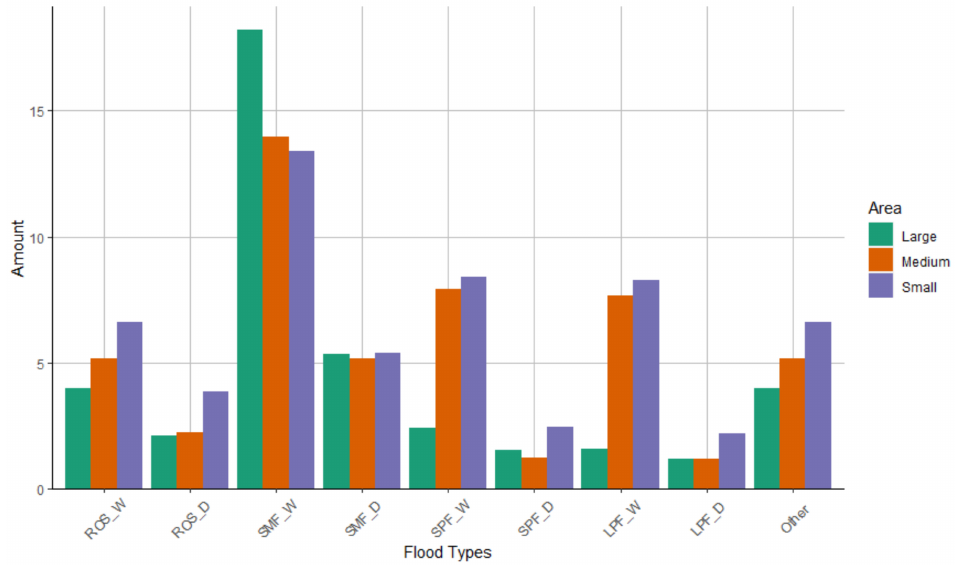
Figure 9. Flood typology classification based on the catchment area